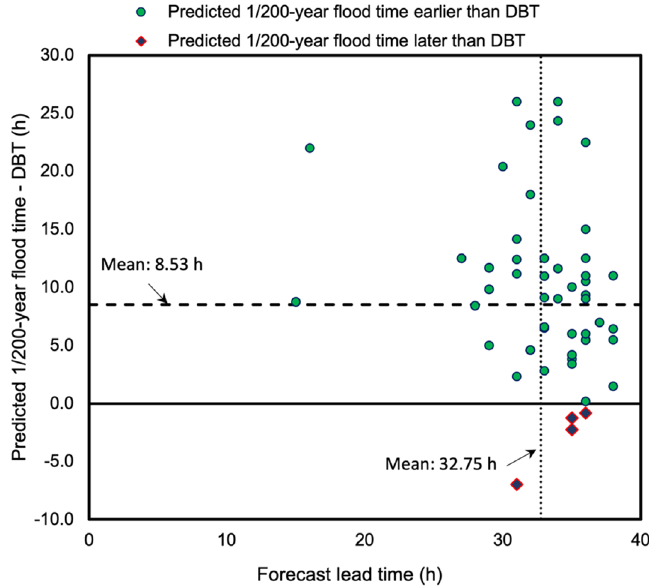
Figure 5. Differences between predicted 1/200-year flood times and DBTs, and the corresponding lead times. The vertical dashed line indicates the average lead time, which is approximately 32.75 h. The horizontal dashed line indicates the average difference between the 1/200-year flood time and the DBT, which is approximately 8.53